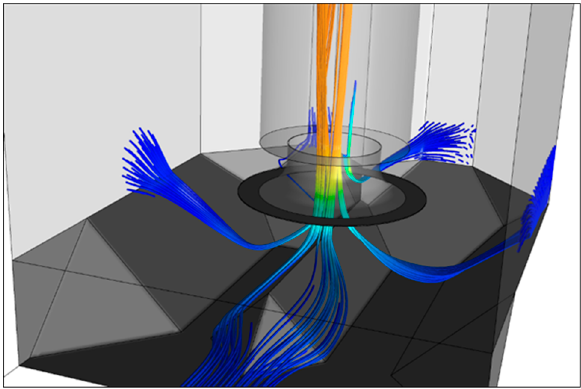
Figure 20. Vector plot showing uniform flow pattern on the sidewalls and sump floor.